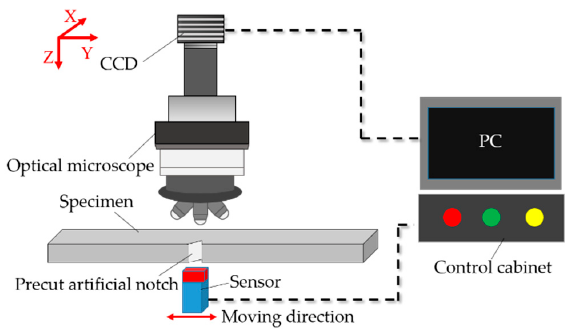
Figure 4. The schematic diagram of plastic deformation observation and MMM signals detection.